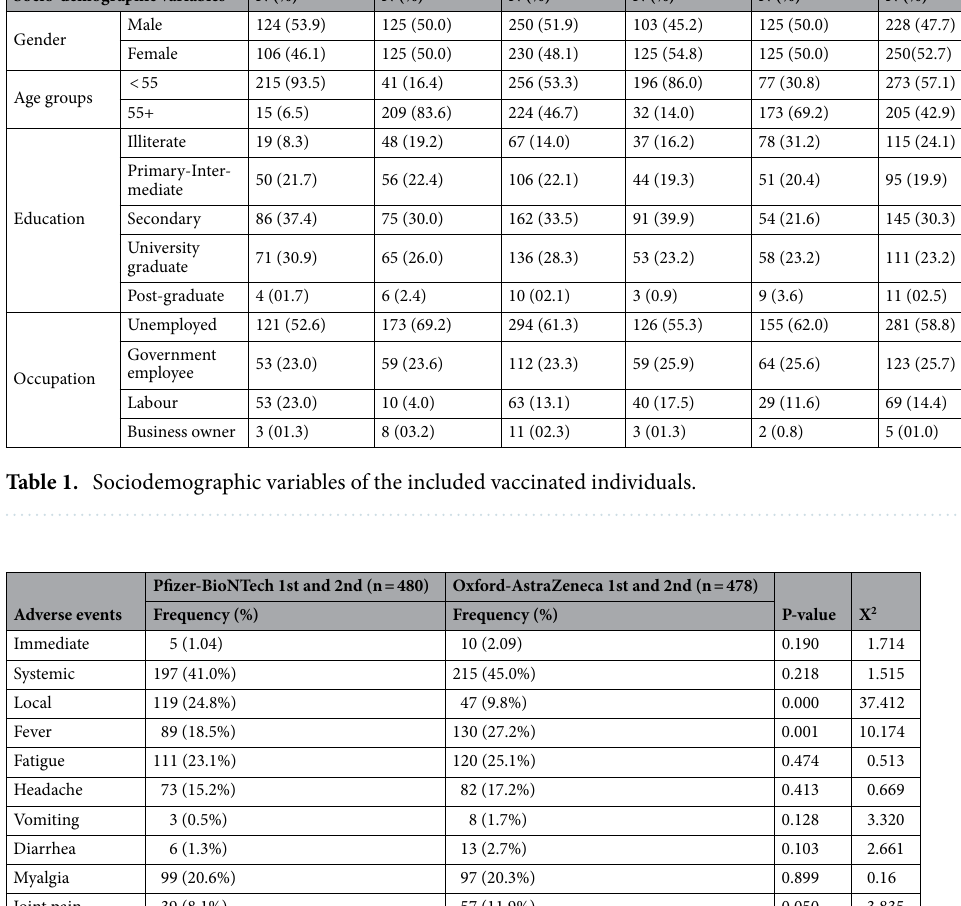
Table 2. Comparison of immediate and short-term adverse events of Pfizer-BioNTech and Oxford- AstraZeneca vaccines among studied participants.